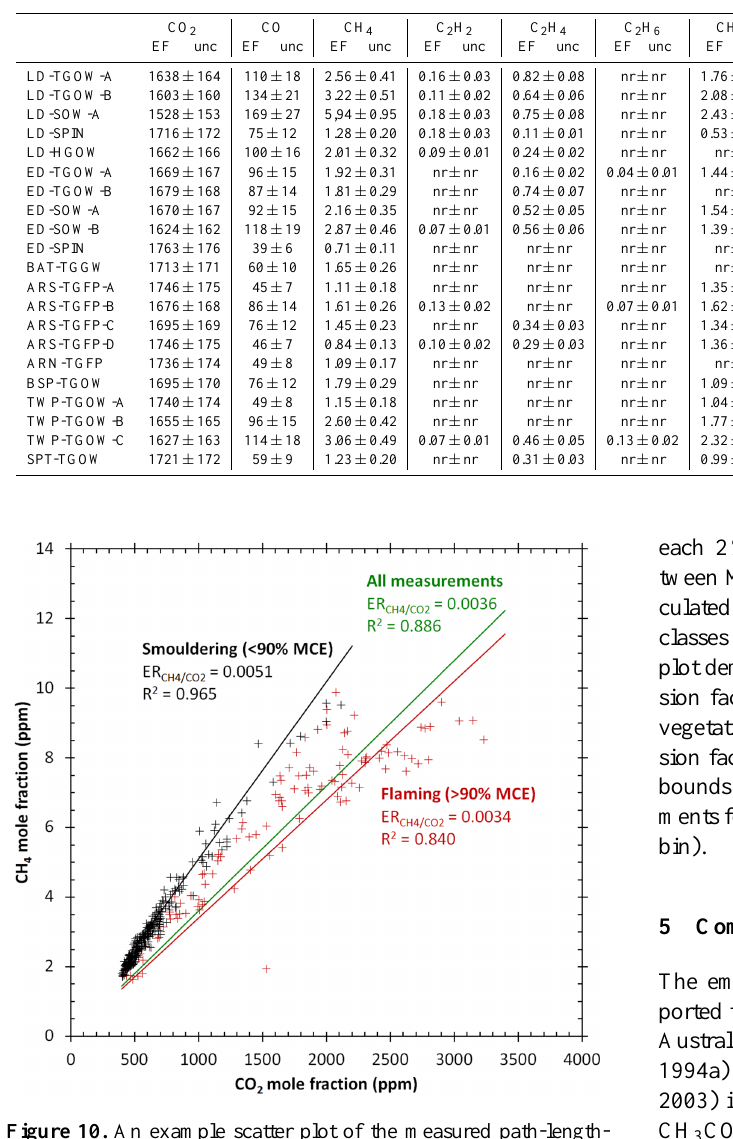
Figure 10. An example scatter plot of the measured path-length- averaged mole fractions of CO 2 and CH 4 (as in Fig. 8, top centre). Here, the data have been split using MCE, with measurements hav- ing an MCE greater than 90% (red) being considered separately to those with a lower MCE (black). Different emission ratios and emis- sion factors for flaming and smouldering emissions can then be de- termined (also shown on the plot in red and black text respectively, the green text indicates the emission ratio and factors determined using all